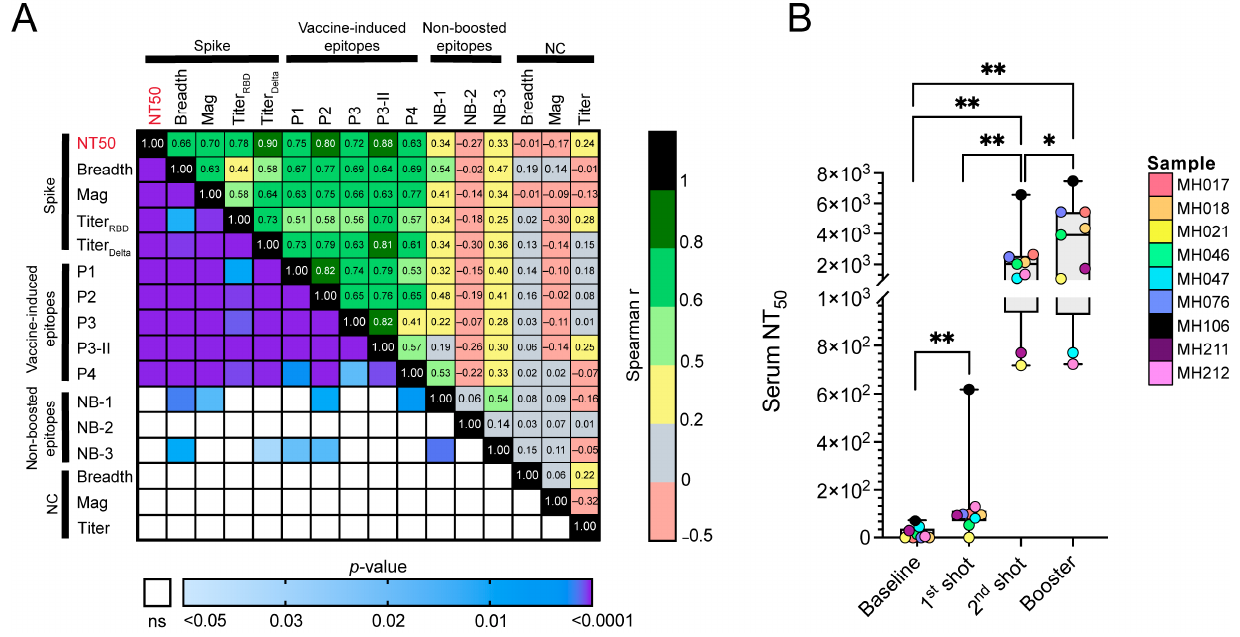
Figure 5. ( A ) Association of vaccine-induced (anti-S) and non-targeted (anti-NC) responses with breadth, magnitude, neutralization, and titer. The upper triangle represents the Spearman correla- tion coefficients, while the lower triangle represents the statistical significance of each correlation, in the order of Spike (S) and vaccine-induced S epitopes, followed by the non-boosted S epitopes, and finally non-targeted nucleocapsid (NC) breadth, magnitude and Ab titer. ( B ) Serum NT 50 trends across timepoints. Statistically significant pairwise comparisons of vaccination timepoints are indi- cated with asterisks (Wilcoxon matched signed-rank test). p -values are denoted: ** p < 0.01, * p < 0.05.